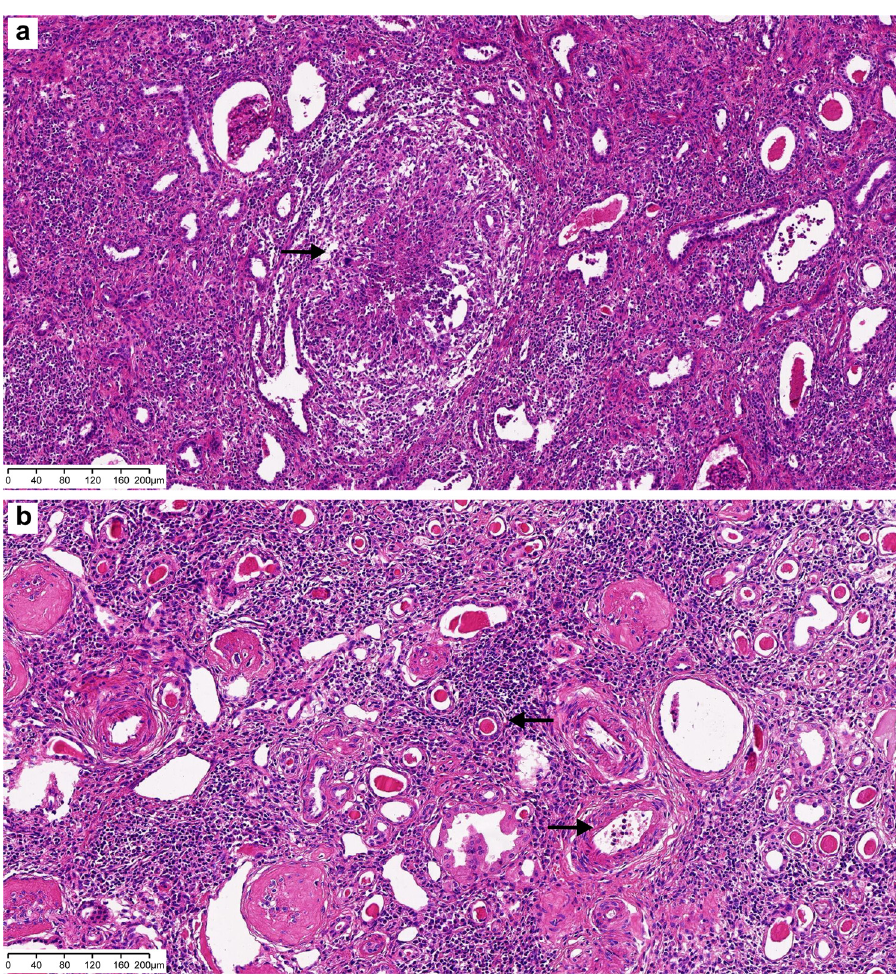
Figure 3: Left kidney tissue sections from the patient showing ( pathological HE staining scale bar: 200 µm ) : ( a ) noncaseating granulomas ( indicated using arrows ) and ( b ) biopsy - based in fi ltration of mixed in fl ammatory cells and thickening of the walls of small renal blood vessels ( indicated using arrows )